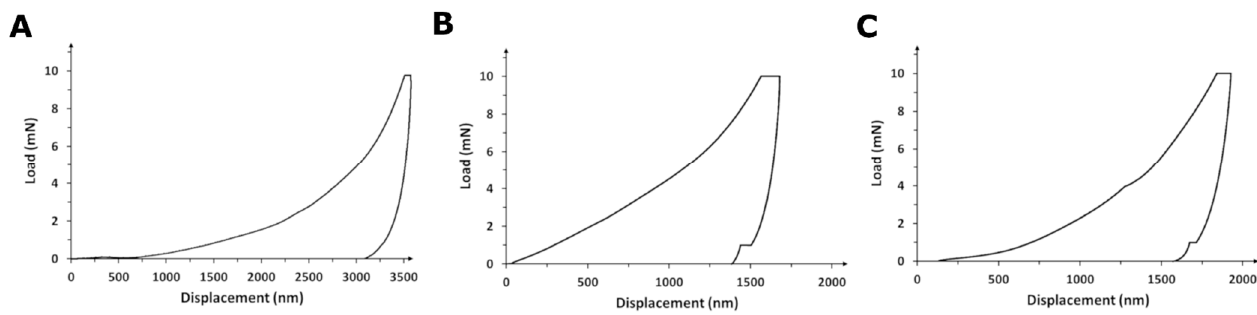
Figure 5. Nanoindentation load–displacement curves obtained for ( A ) the MWCNTs coating, ( B ) the MWCNTs/TiO 2 coating, and ( C ) the MWCNTs_Cu coating. Table 3. Mechanical properties and maximum indent depth for the substrate and tested coatings.